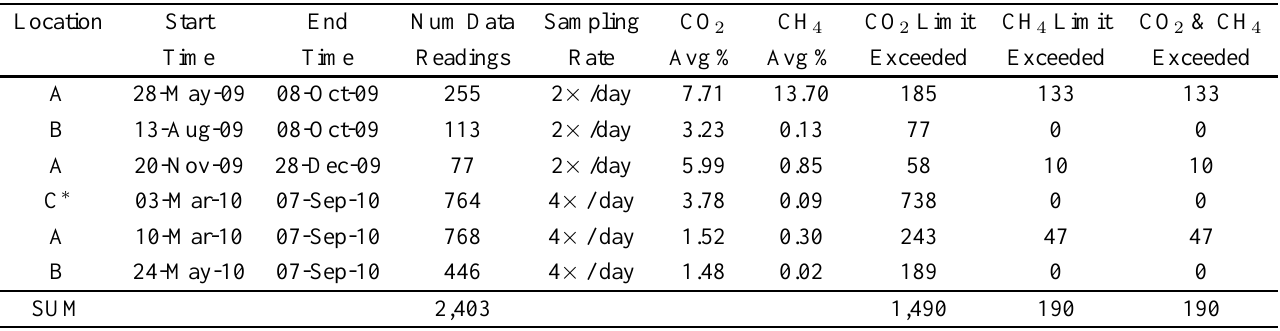
Table 1. Field deployment data gathered over a 16 month period. For location C a 9 minutes sample only approach was taken, as opposed to baseline + sample + purge.